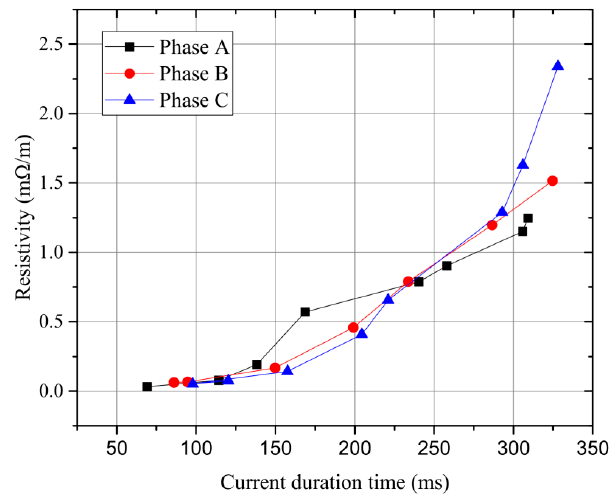
Figure 16. The curves of the maximum resistance.